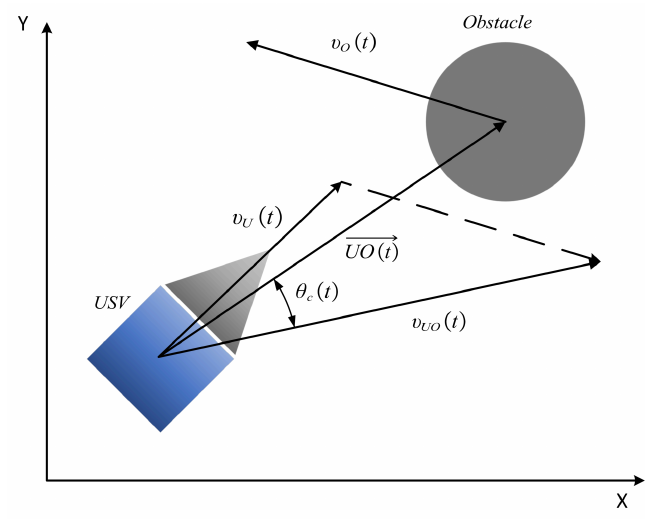
Figure 5. Relative speed and collision angle between USV and